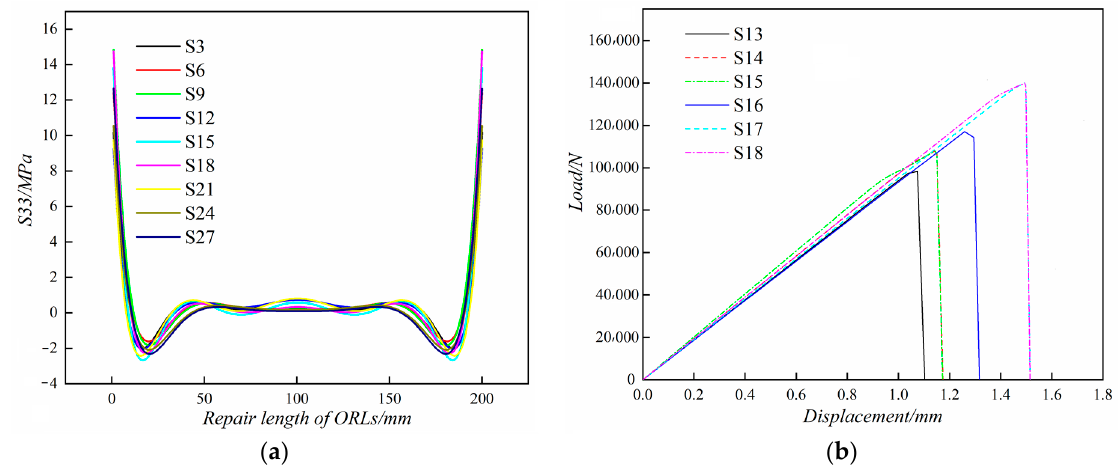
Figure 15. Analysis results of structural repair model: ( a ) cohesive layer normal stress S33 corre- sponding to RL = 200 mm; ( b ) failure load–displacement curve.